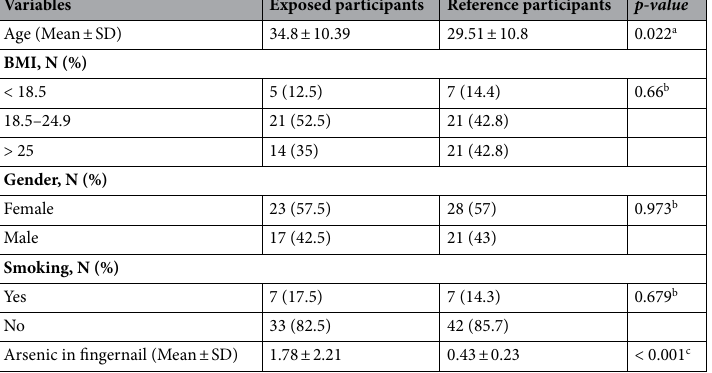
Table 2. The studied variables in the two exposed and referenced groups. SD standard deviation. a Independent-samples T-test. b Chi-square test. c Mann–Whitney U